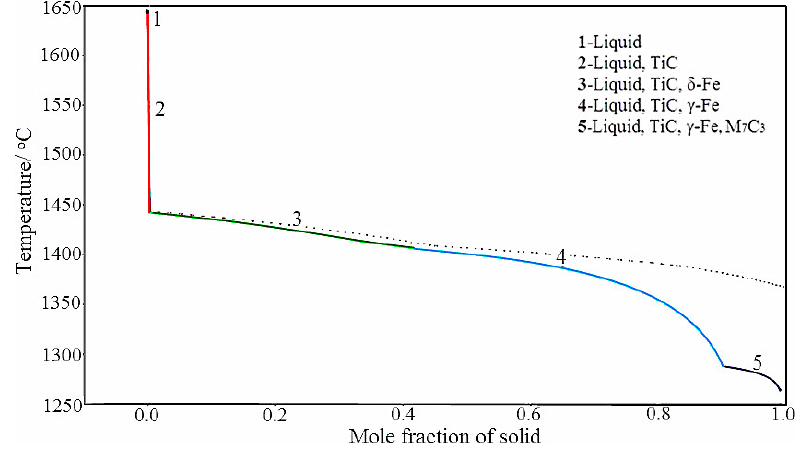
Figure 12. Mole fraction of solid phase as a function of temperature during non-equilibrium solidification.